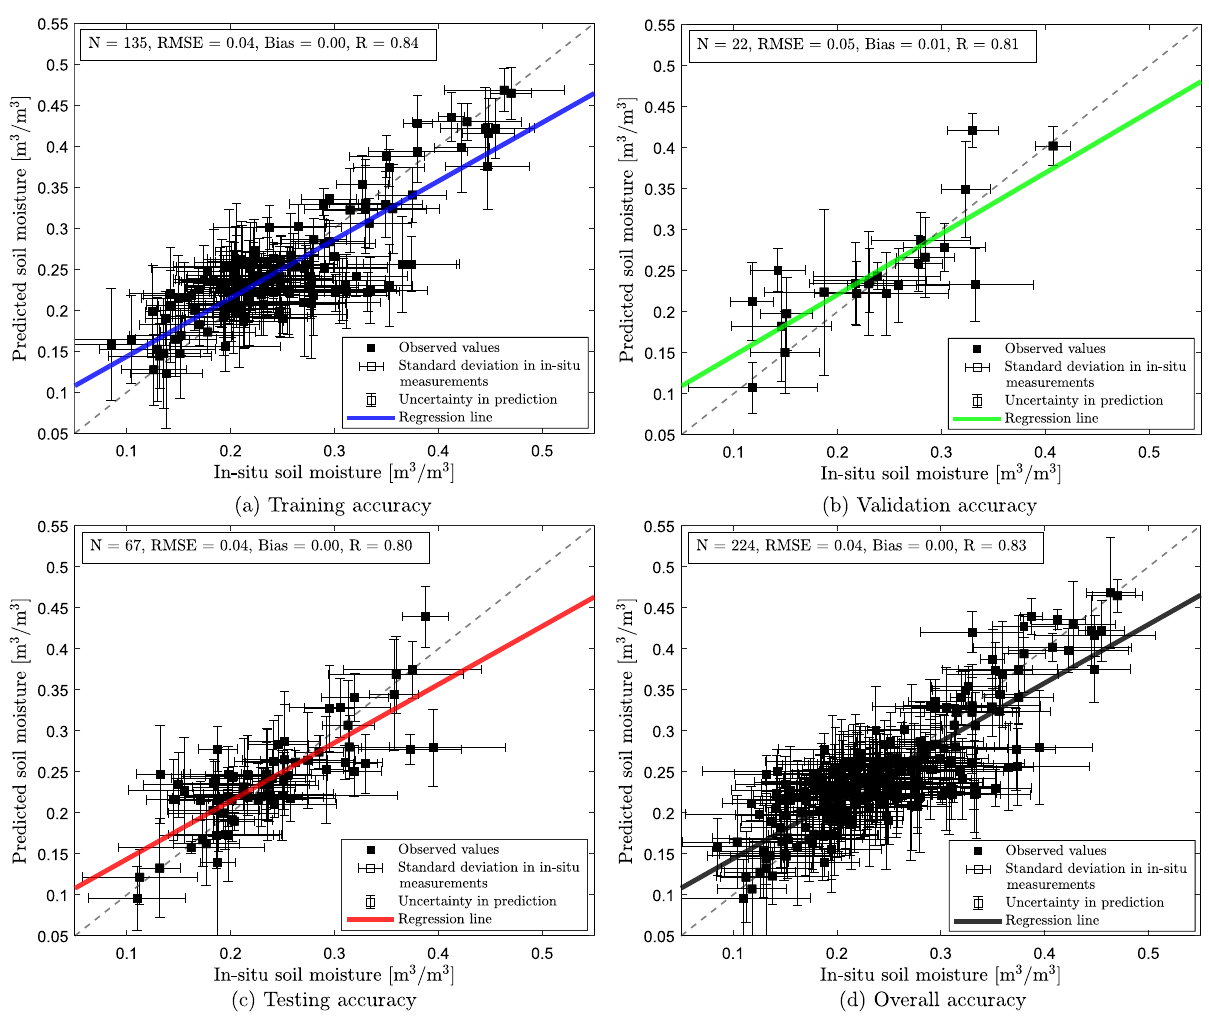
Figure 8. Model performance on ( a ) training, ( b ) validation, ( c ) testing, and ( d ) complete datasets. The dashed line in figure a-d represents y = x line. Horizontal error bar represents the standard deviation of the in-situ measurement, and vertical error bar represents the resulting uncertainty in the model